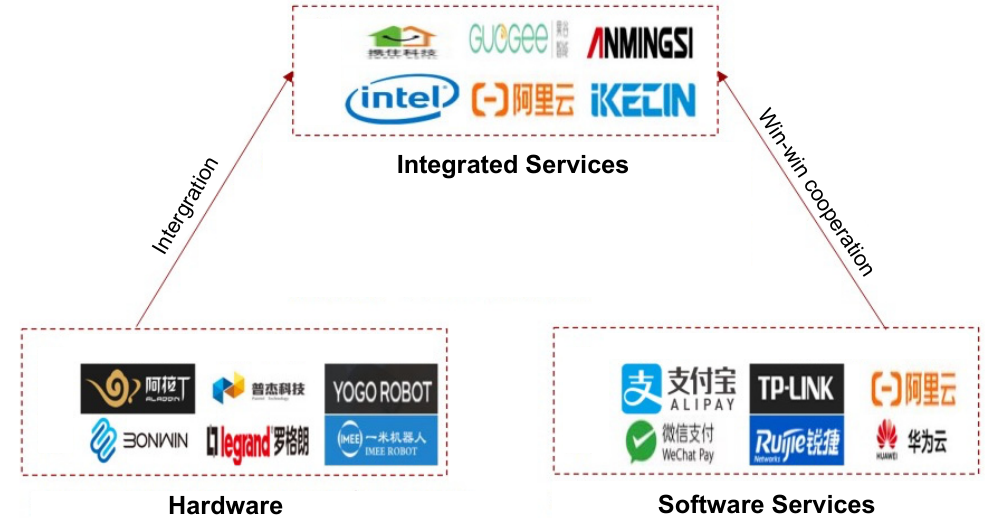
Figure 9. Midstream of the hospitality industry chain of hotel IoT applications.